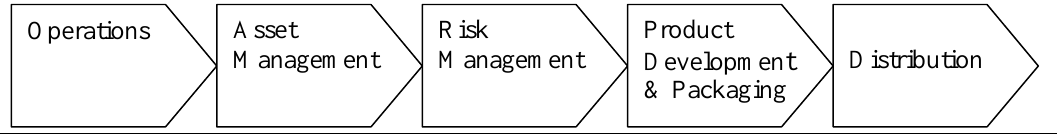
Figure 1: combined value chain